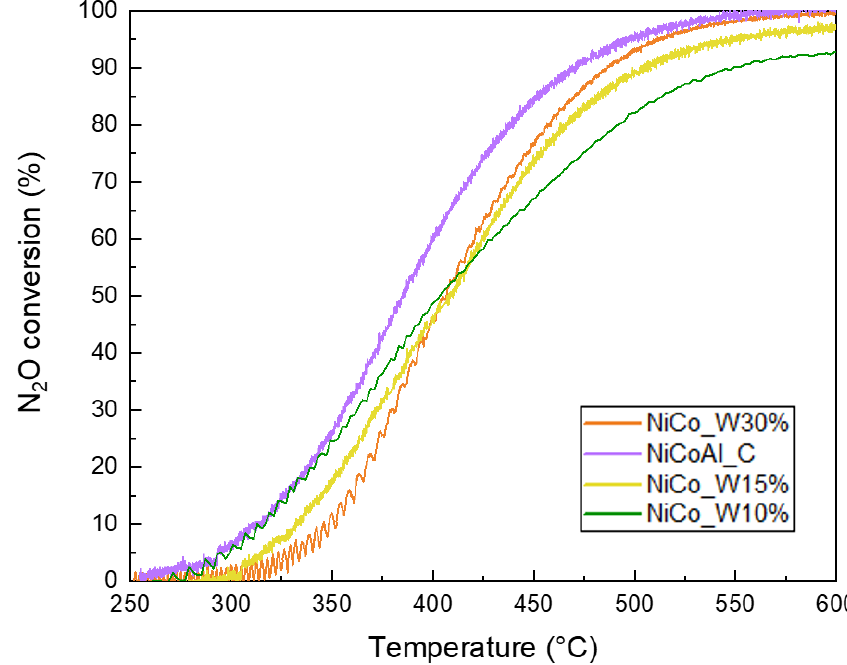
Figure 12. Activity comparison for the alumina-containing formulations. Operating conditions: GHSV = 15,000 h − 1 , 1 atm, reagent mixture: 10 vol% N 2 O in Ar.